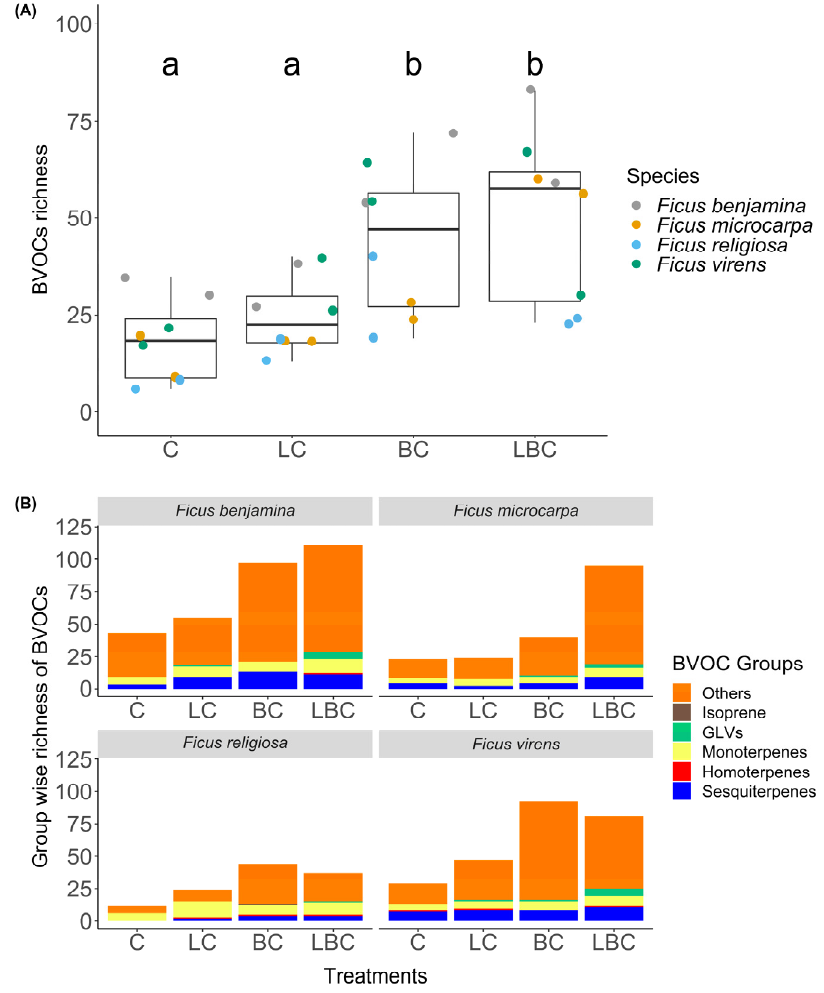
Figure 2. ( A ) Boxplots showing BVOCs richness with respect to the experimental treatments across four Ficus species. Letters in ( A ) represent statistically significant differences between the treatments based on post hoc pairwise tests. ( B ) The total richness of BVOCs categorized into six groups (see Methods for more details) among the experimental treatments for each species. C = control, LC= leaf-cutting, BC = branch-cutting, and LBC = leaf-branch-cutting.